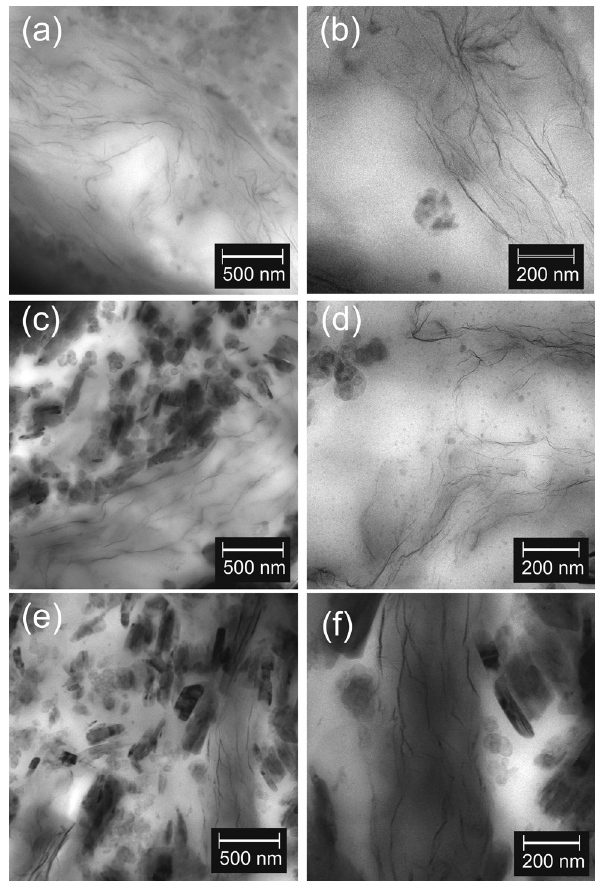
Figure 2: TEM images of BR/CR rubber nanocomposites at 8,000 × ( left column ) and at 20,000 × magni fi cation ( right column ) , ( a + b ) BR/CR/MLG3/CB5, ( c + d ) BR/CR/ATH47/MLG3/CB20, and ( e + f )